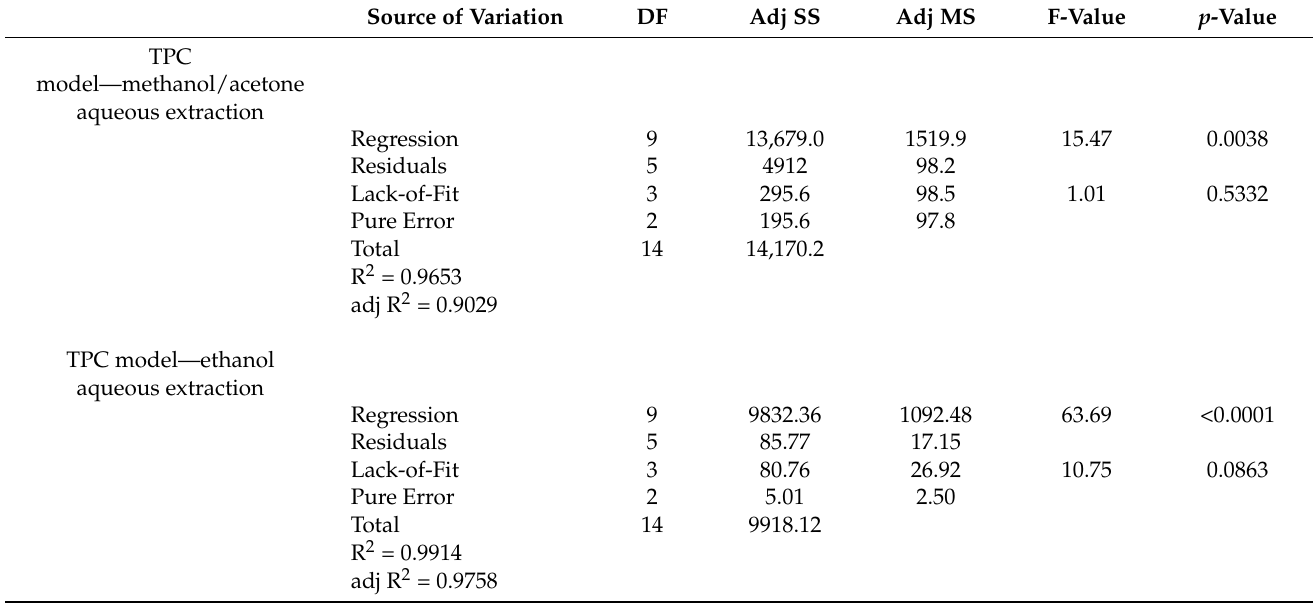
Table 3. Analysis of variance (ANOVA) of the second-order polynomial models for